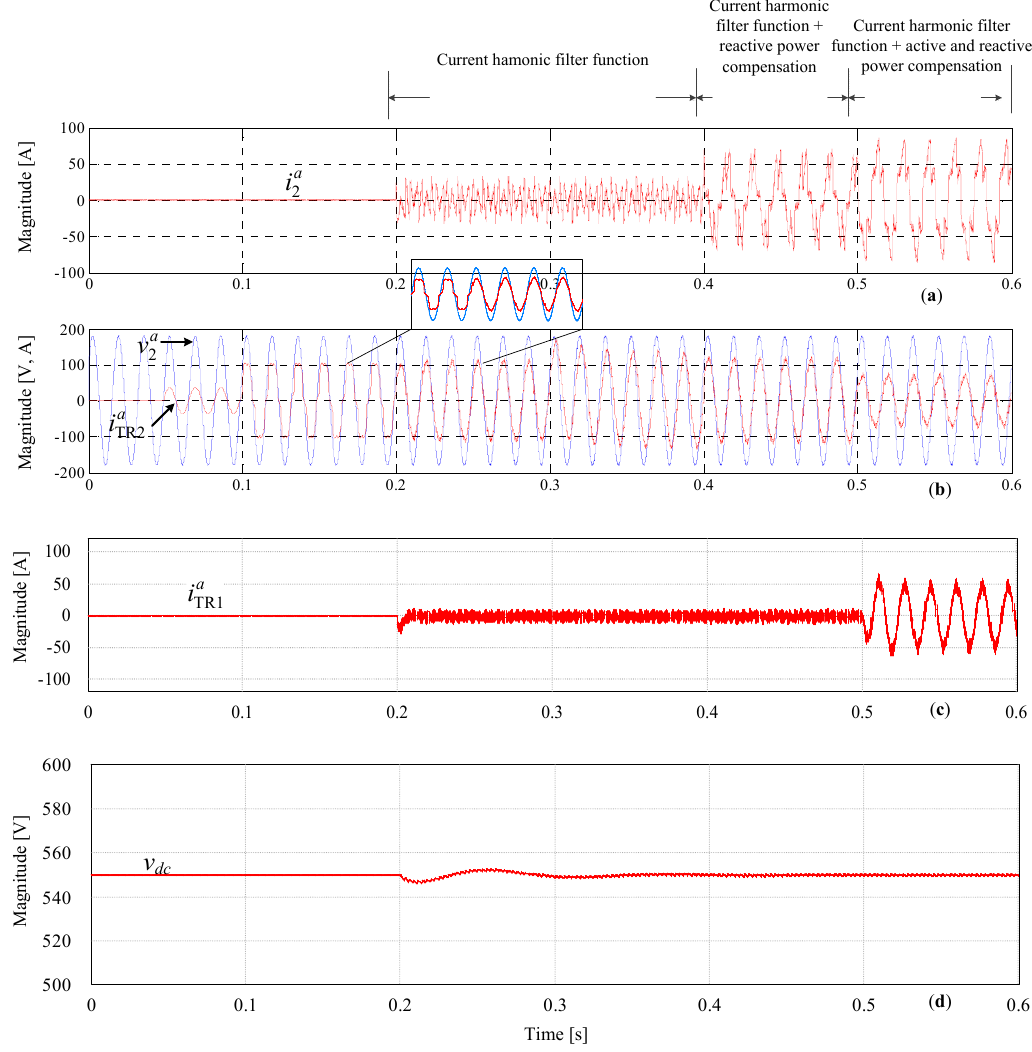
Figure 10. Before and after compensation for the BTB-VSC. ( a ) Current for phase a injected to the PCC2 by the BTB-VSC. ( b ) Voltage and current for phase a at the PCC2. ( c ) Current for phase a measured at the PCC1. ( d ) DC bus voltage.